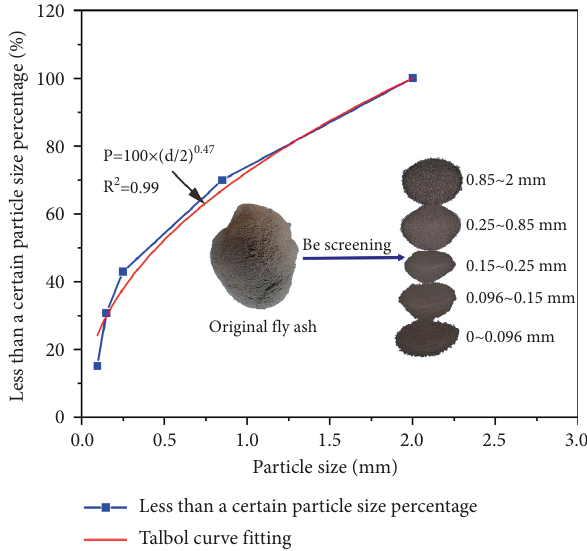
Figure 4: Particle size gradation curve of fly